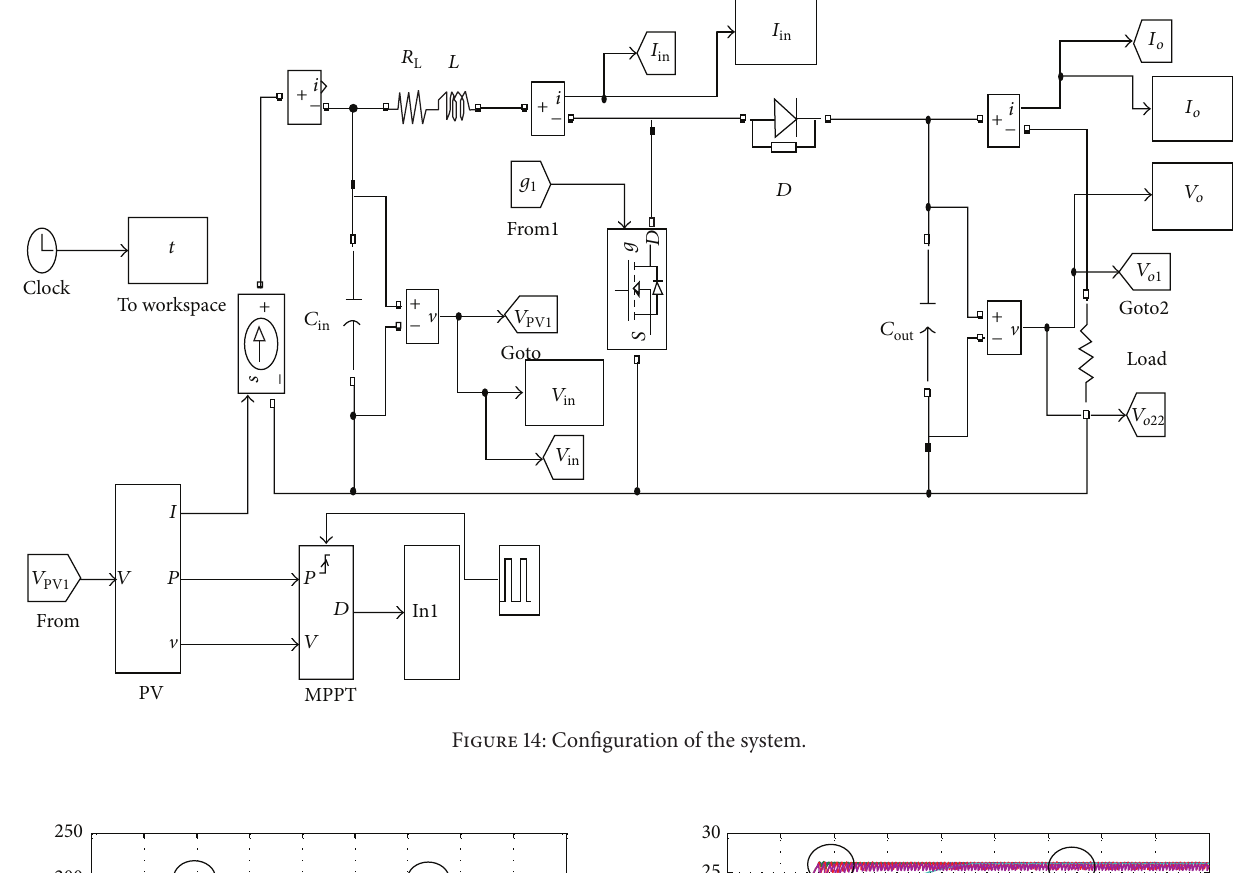
Figure 14: Configuration of the system.